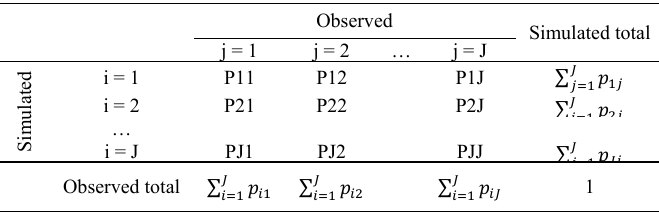
Table 3: Layout of projected population matrix (Pontius and Millones 2011)